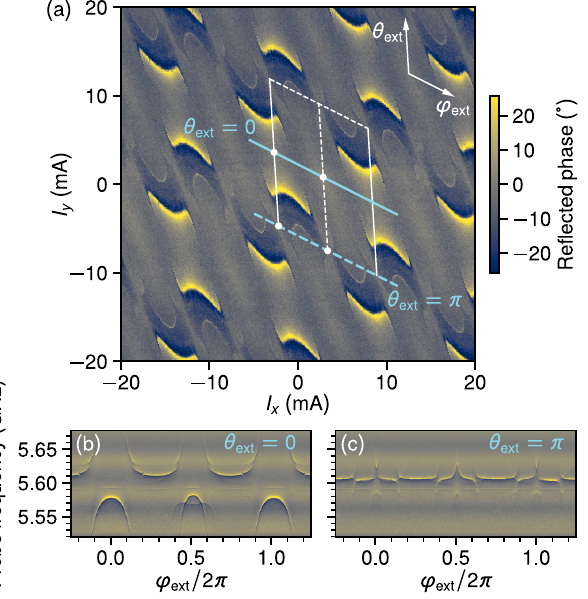
FIG. 4. Device flux dependence. (a) Phase of the reflected probe signal (color) on the readout port, at the fixed probe frequency of 5.595 GHz, as a function of both flux bias currents I and I . The overlaid lines indicate the independent φ and θ x y ext ext axes, while dots mark points of inversion symmetry. This phase response signals the periodic approach of the circuit transition energies in the vicinity of the readout resonance. (b),(c) Phase of the reflected probe signal (color) on the readout port, as a function of probe frequency and external flux φ at zero and half flux ext [solid and dashed blue lines in (a)], displaying periodic avoided